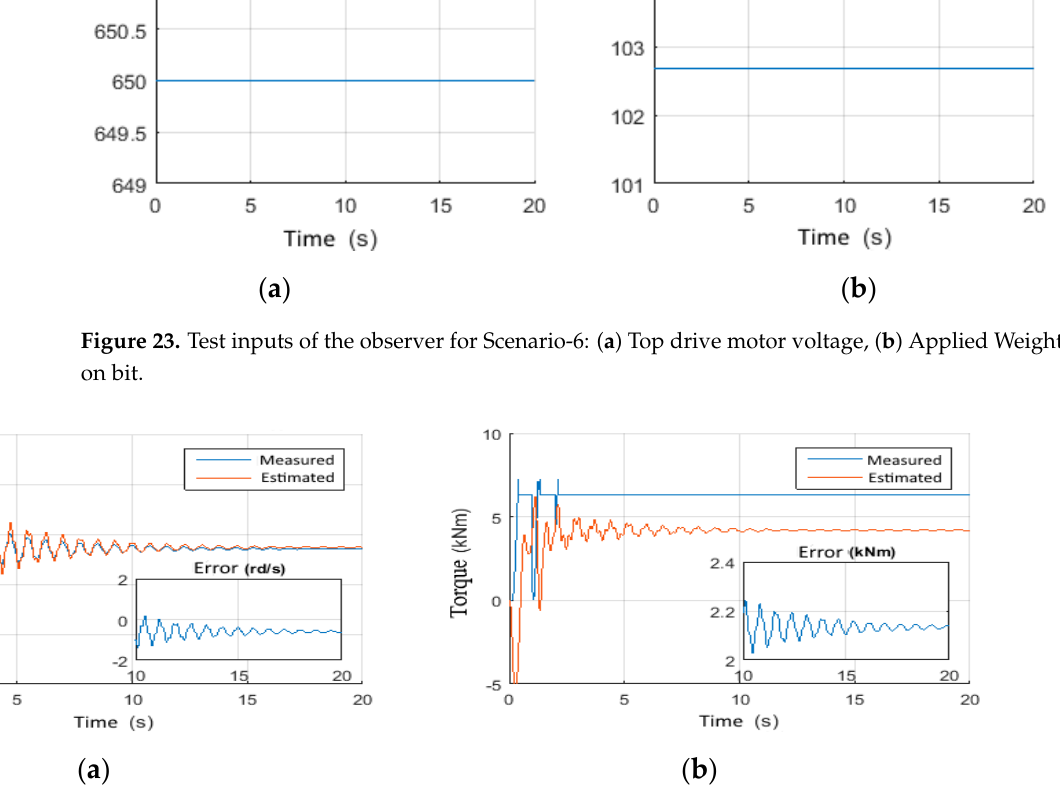
Figure 24. Measured and estimated variables by the designed Observer for Scenario-6: ( a ) Rotational